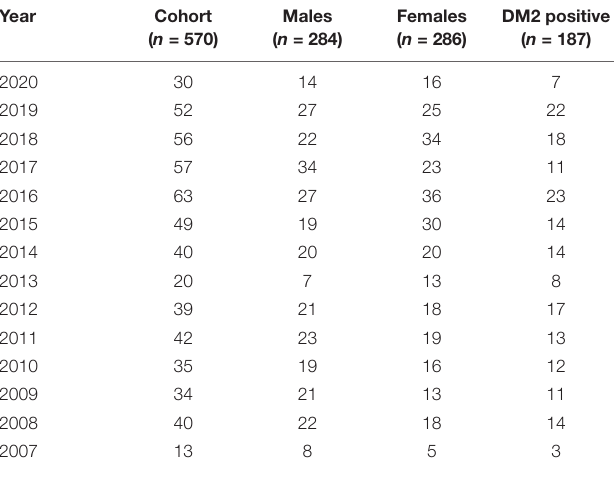
TABLE 1 | DM2 genetic tests requested to our lab in the period between 2007 and